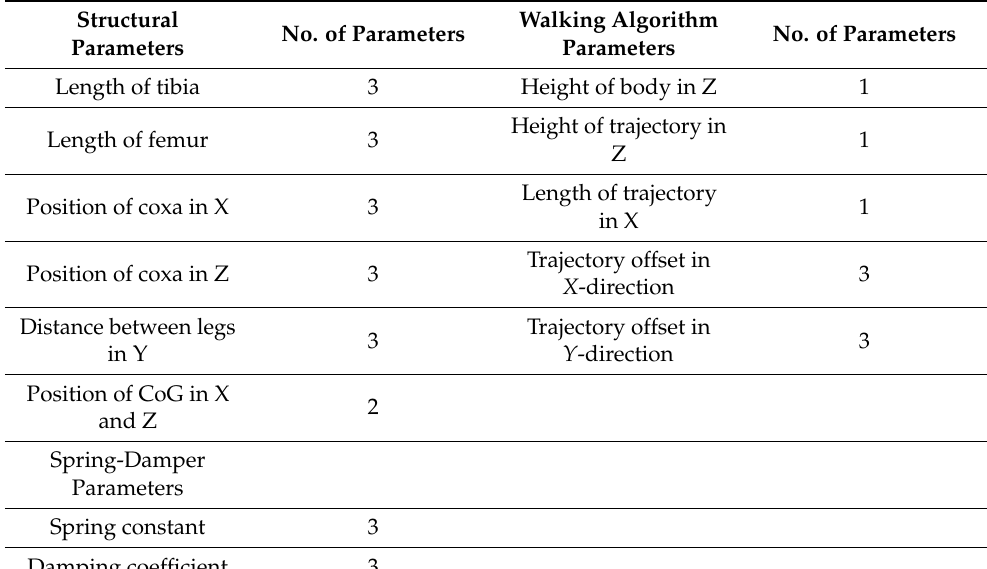
Figure 5. ( a ) Positioning of the leg pairs on the body along the x - and z -axis. ( b ) Length of the tibia and femur segments. ( c ) Distance between the legs within a pair of legs. ( d ) Positioning of the center of gravity along the x - and z -axis. Table 5. Optimization parameters.